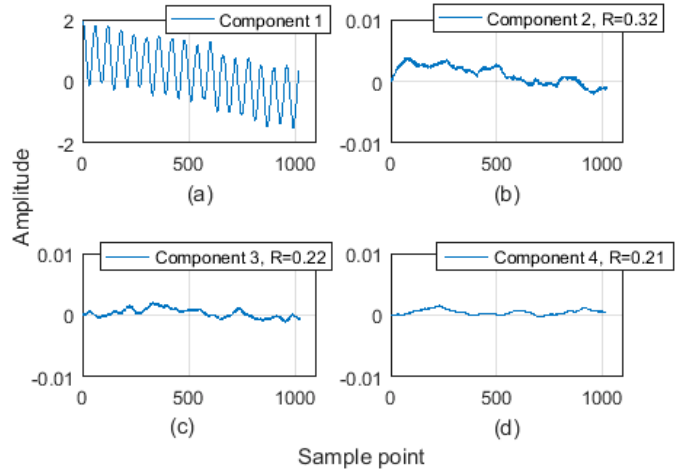
Figure 2. De-noising results of each component by using augmented nonlinear differentiator (AND) with determined R s: ( a ) component 1 without de-noising; ( b ) component 2 denoising result with R = 0.32; ( c ) component 3 denoising result with R = 0.22; ( d ) component 2 denoising result with R = 0.21.